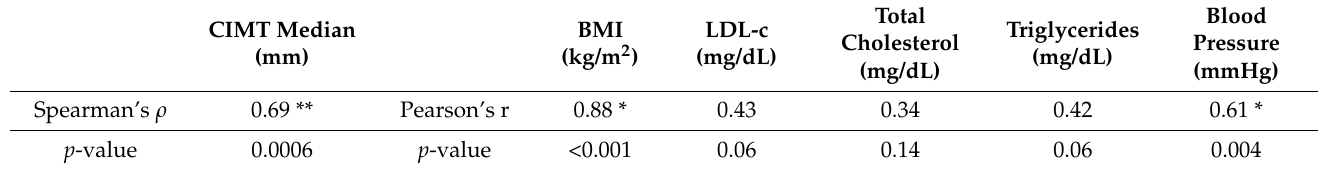
Table 6. Correlations between waist circumference and other parameters in obese children.